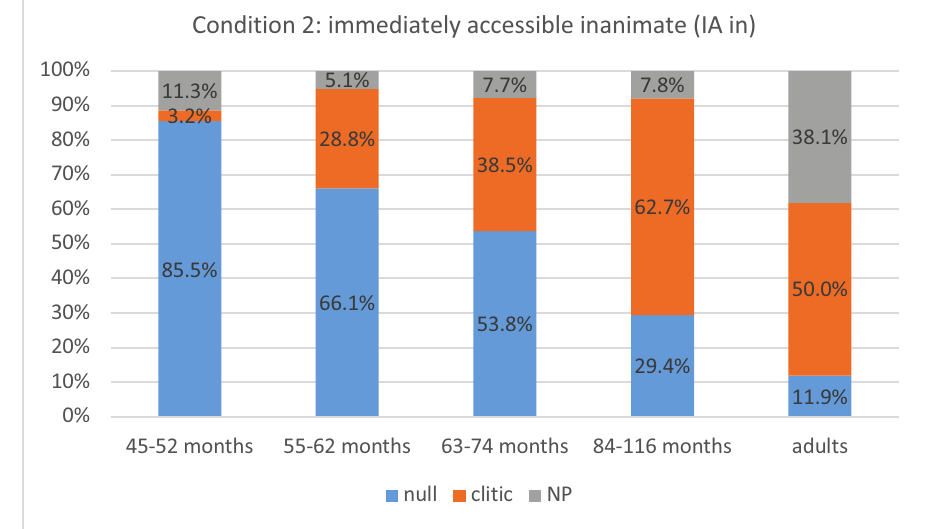
Figure 4: Distribution of null, clitic and NP objects in Condition 2 (IA